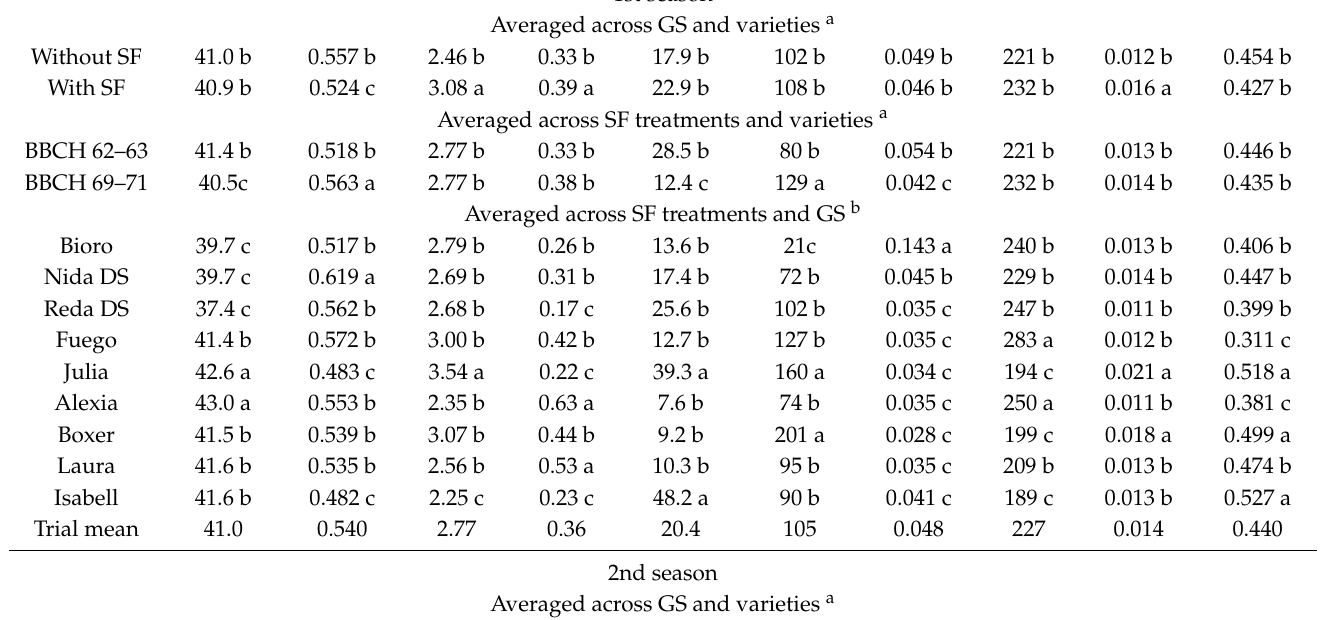
Table 3. The effects of seed fungicide (SF), growth stages (GSs), and variety on physiological traits of faba bean.